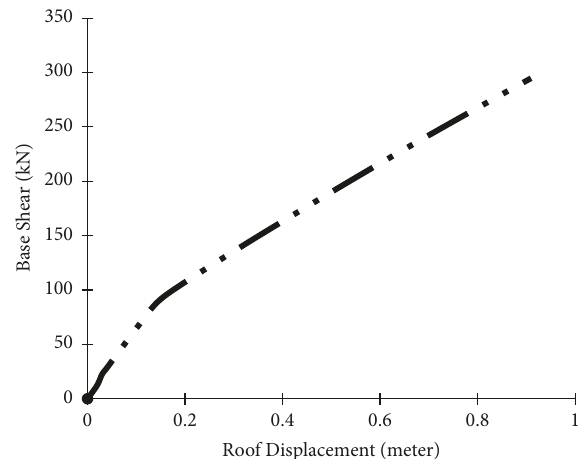
Figure 17: Glulam braced portal frame pushover curve.